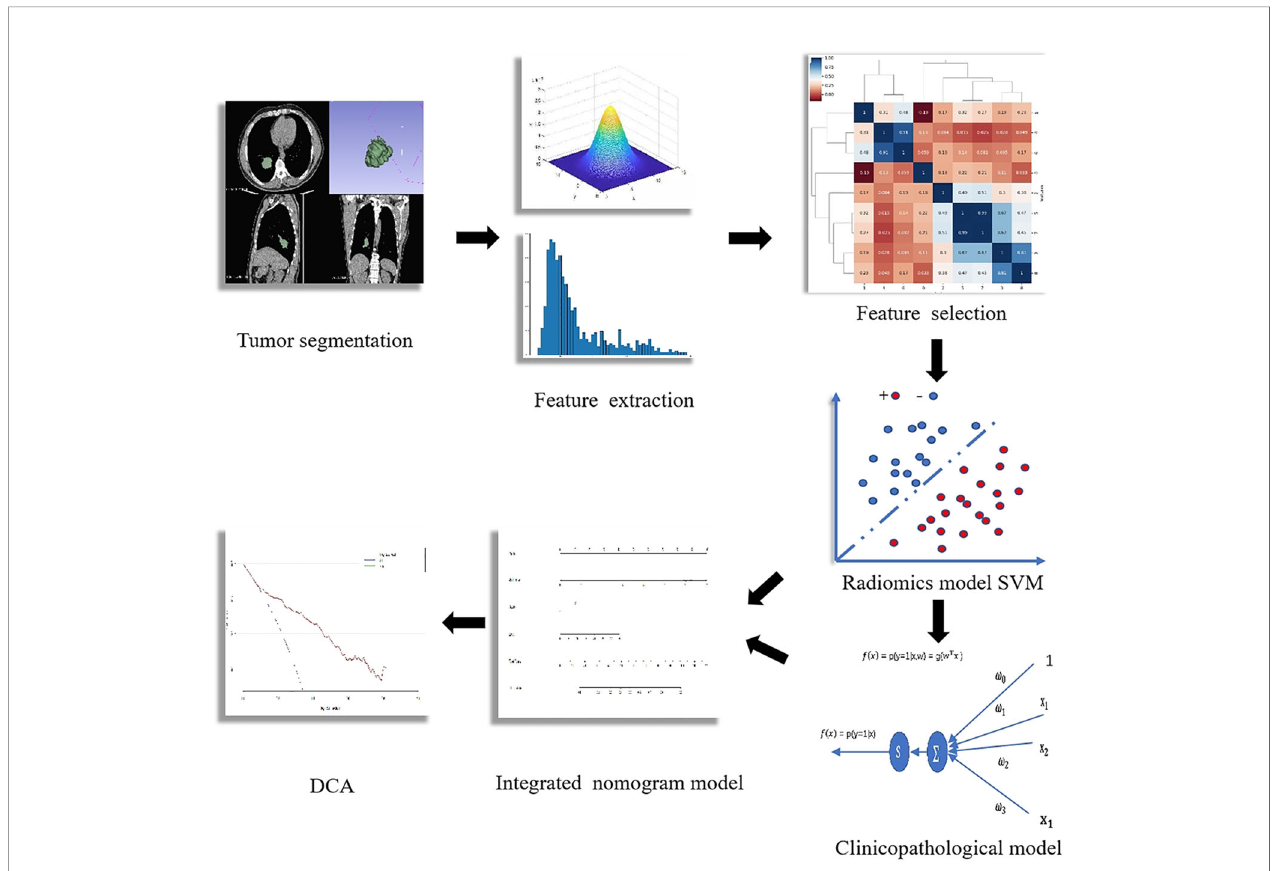
FIGURE 1 | Work fl ow of the radiomics